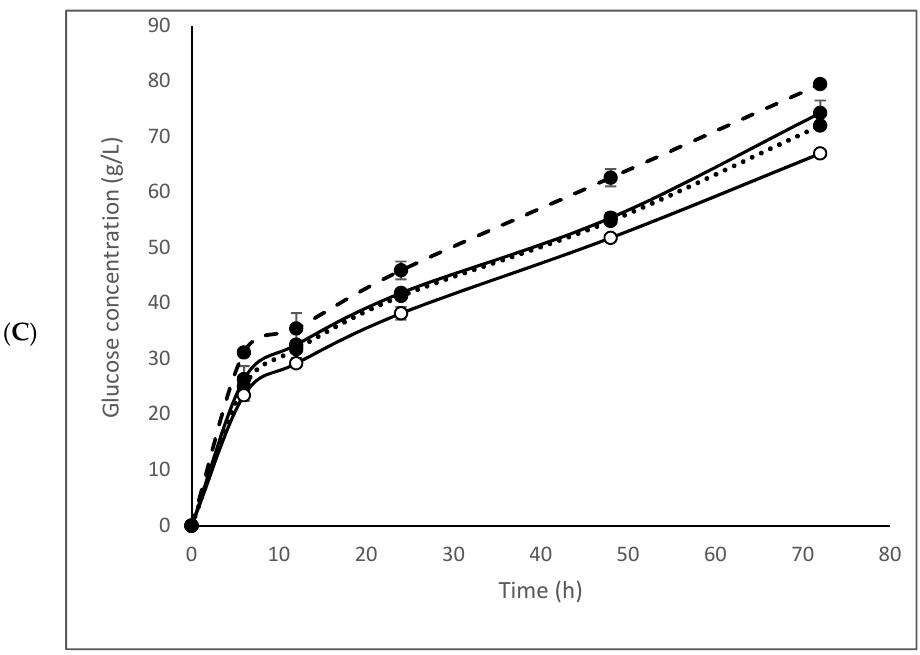
Figure 6. Enzymatic hydrolysis kinetics for surfactant loading increase. ( A ) PEG 400; ( B ) PEG 400 + Tween 80 mixture; ( C ) PEG 1500. (—) 0.2 g surfactant/g substrate; ( ··· ) 0.4 g surfactant/g substrate; ( ○ ) 0.6 g surfactant/g substrate; (- -) Control.